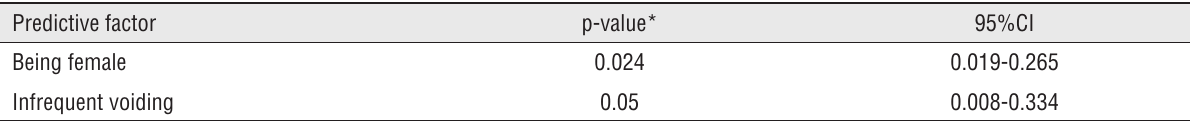
Table 3 - Febrile urinary tract infection in children and adolescents with overactive bladder: multivariate analysis. Predictive